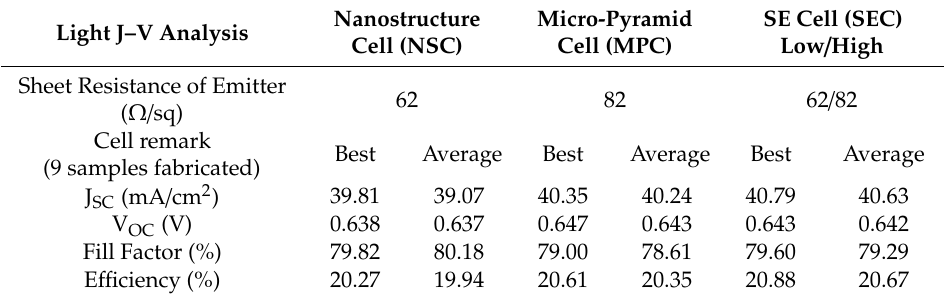
Table 1. Best and average solar cell characteristics according to surface structure with a comparison of sheet